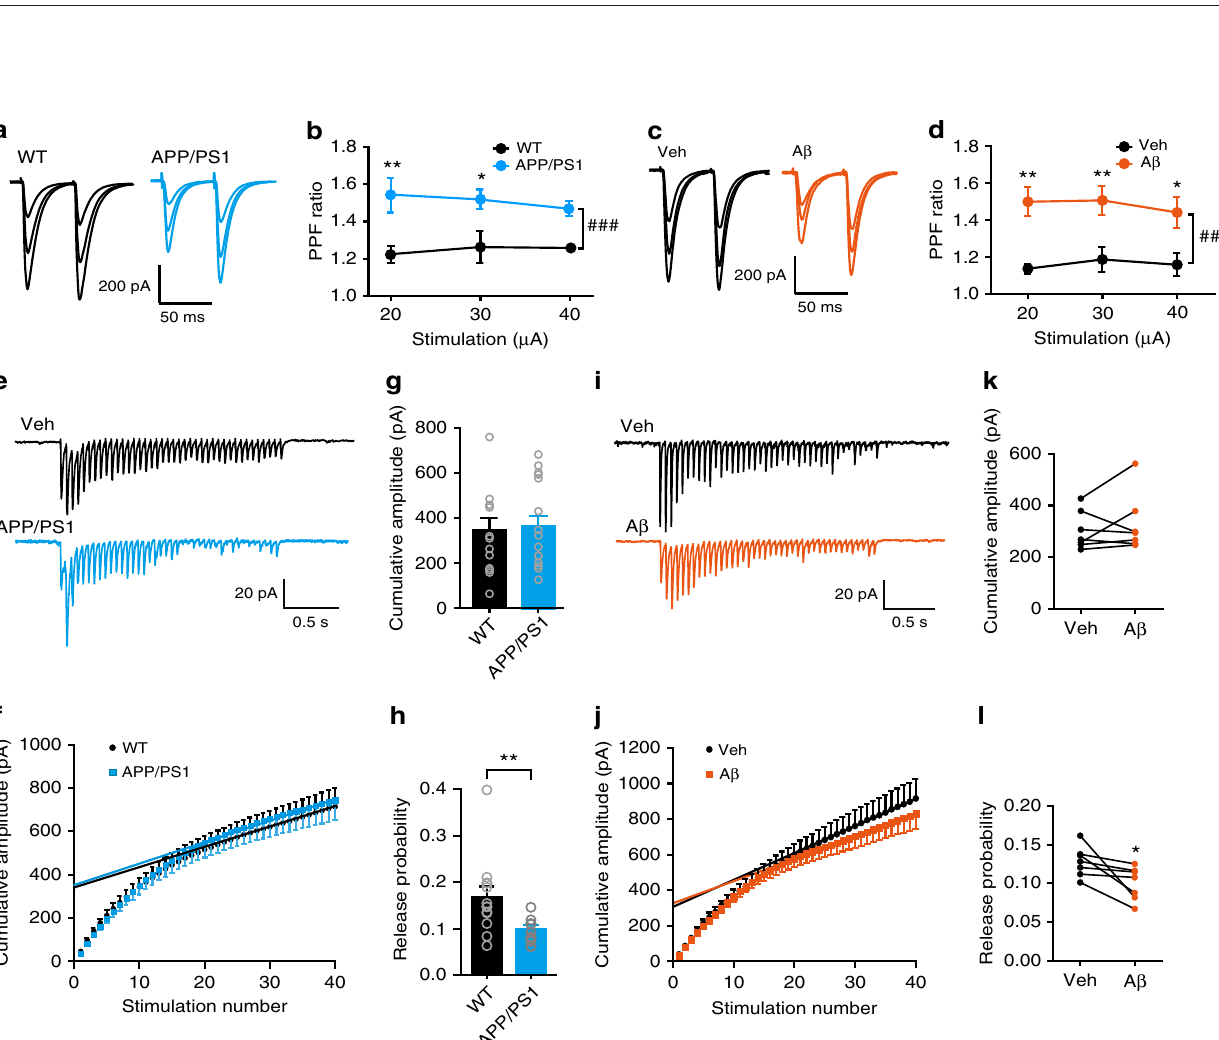
Fig. 1 Excitatory synaptic de fi cits in 6 – 7-month-old APP/PS1 mice involve a presynaptic mechanism independent of altered bouton density. a – c Representative Golgi staining of apical dendrites ( a ) and quanti fi cation of density of different types of spines ( b ) and total spine density ( c ) in CA1 pyramidal neurons in WT and APP/PS1 mice. Bar, 5 μ m. t test; *, P < 0.05; N = 10 – 19 per group. d , e Representative traces ( d ) of mEPSCs in CA1 pyramidal neurons and cumulative plots and mean values (insets) ( e ) of mEPSC amplitude (left) and frequency (right) in WT and APP/PS1 mice. Kolmogorov- Smirnov test (cumulative plots), *** P < 0.001; t test (insets), ** P < 0.01; N = 10 – 11 per group. f , g Representative traces of SC-CA1 EPSCs evoked by stimulus intensities of 10, 30, and 100 μ A ( f ) and quanti fi cation of EPSC amplitude to stimulus intensity ( g ) in WT and APP/PS1 mice. Two-way ANOVA with post hoc Bonferroni test; animal, F (1,132) = 30.22, P < 0.001; stimulation, F (10,132) = 27.23, P < 0.001; *** P < 0.001; N = 5 – 9 per group. h , i Representative traces ( h ) of mEPSCs in CA1 pyramidal neurons and quanti fi cation ( i ) of mEPSC amplitude (left) and frequency (right) in WT hippocampal slices before (vehicle, Veh) and after A β treatment. t test; * P < 0.05; *** P < 0.001; N = 10 per group. j , k Representative traces of SC-CA1 EPSCs evoked by stimulus intensities of 10, 20, 100 μ A ( j ) and quanti fi cation of EPSC amplitude to stimulus intensity ( g ) in WT hippocampal slices before (Veh) and after A β treatment. Two-way ANOVA with post hoc Bonferroni test; animal, F (1,132) = 244.0, P < 0.001; stimulation, F (10,132) = 83.89, P < 0.001; *** P < 0.001; N = 7 per group. l , m Representative images of FM1 – 43-labeled active boutons ( l ) and quanti fi cation of relative FM1 – 43-labeled bouton density ( m ) in cultured hippocampal neurons treated with Veh or A β . Bar, 50 μ m. t test; P > 0.05; N = 10 – 11 per group. Data are mean ± SEM. CF cumulative frequency. Source data are provided as a Source Data fi le